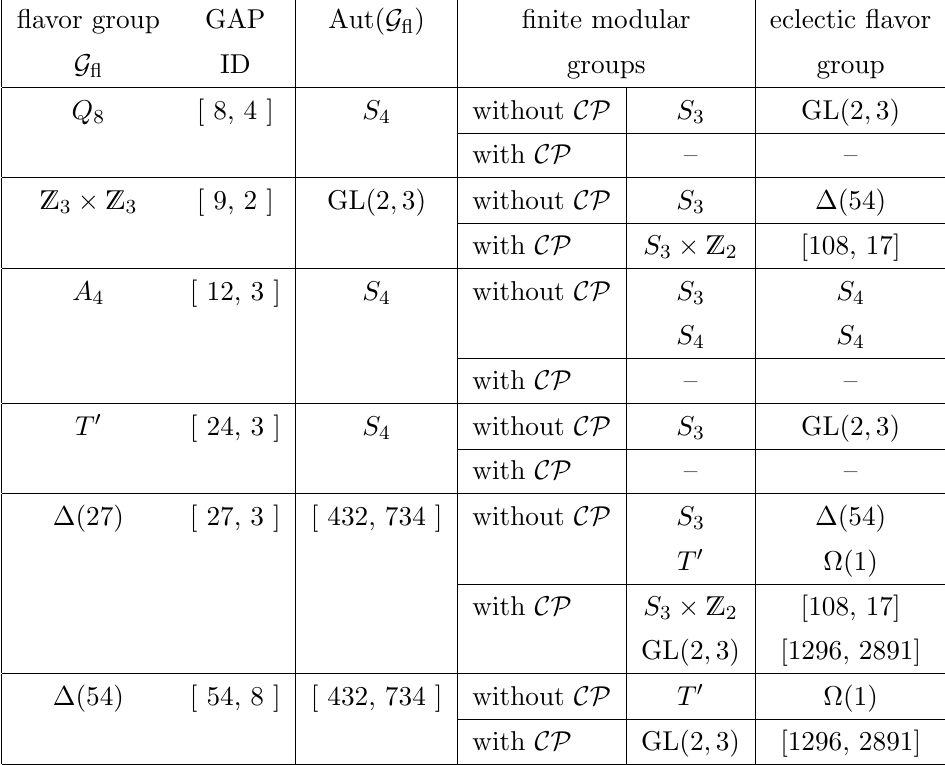
Table 2 . Examples of traditional (cid:13)avor groups, their extensions by (cid:12)nite modular groups and the resulting eclectic (cid:13)avor groups. For details, see appendix B. Aut( G (cid:13) ) denotes the group of automorphisms of the traditional (cid:13)avor group G (cid:13)